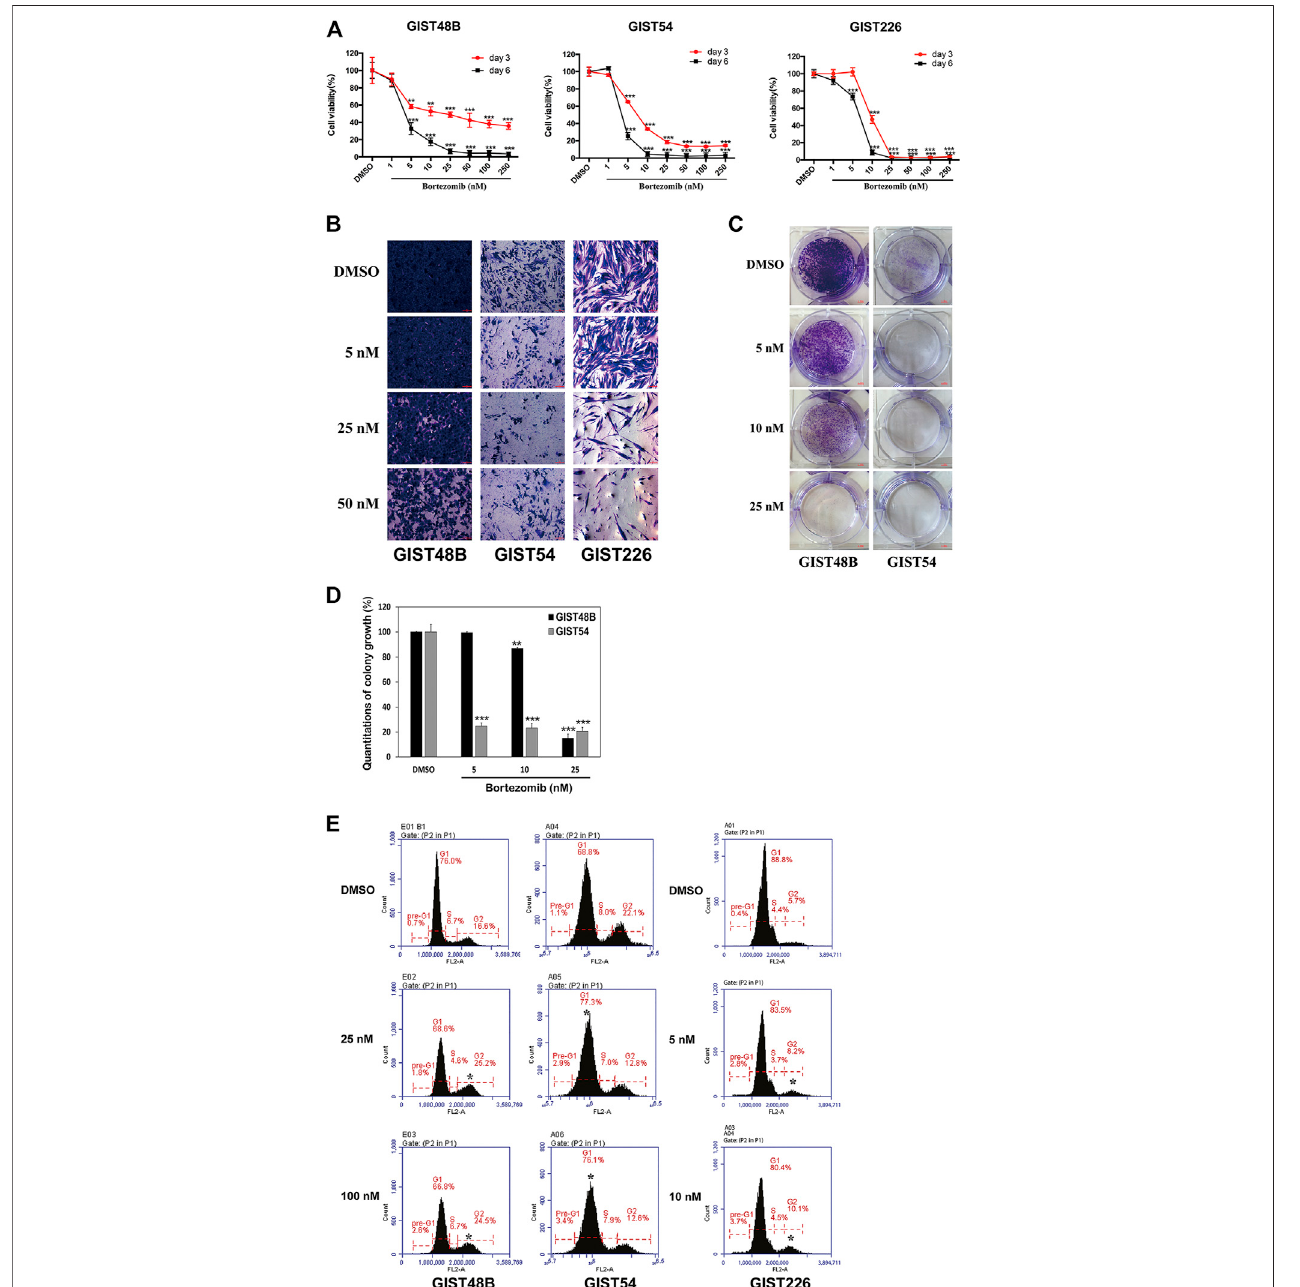
FIGURE3| Anti-proliferativeeffectsofbortezomibinKIT-independentGISTcelllines(GIST48B,GIST54,andGIST226)wereassessedbycellviability,cellimaging, colonyformationassays,andcellcycleanalysis. (A) CellviabilitywasevaluatedbyMTTassaysinGIST48B,GIST54,andGIST226celllines,3and6daysaftertreatment with bortezomib (1, 5, 10, 25, 50, 100, and 250 nM). Data were normalized to DMSO control and represent the mean values ( ± s.d.) from quadruplicate cultures, and were averaged from two independent experiments. Statistically signi fi cant differences between DMSO control and bortezomib treatment are presented as ** p < 0.01, *** p < 0.001. (B) Cell culture appearance of GIST48B, GIST54, and GIST226, when evaluated at 72, 48, and 48 h after treatment with bortezomib (5, 25, and 50 nM) and staining with crystal violet, showing dramatic growth inhibition compared to DMSO-treated control cultures. Scale bars: 100 μ m. (C) Colony growth assays were performed at 7 days after treatment with bortezomib (5, 10, and 25 nM). Colony growth experiments were performed in triplicate. Bortezomib treatment led to a greater reduction in colony formation and size in GIST48B and GIST54 than the DMSO control. (D) Quantitation (A 570 ) of GIST48B and GIST54 cell colony growth after treatmentwithbortezomibfor7 days.Statisticallysigni fi cantdifferencesbetweenuntreatedcontrolandbortezomibtreatmentsarepresentedas** p < 0.01,*** p < 0.001. (E) Cell cycle analysis was performed 72 h after treatment with bortezomib (25 and 100 nM). GIST48B, GIST54, and GIST226 showed a cell population increase in G1/ G2-phase, accompanied by a decrease in G2/G1-and S-phase. Cell cycle experiments were performed in triplicate. Statistically signi fi cant differences between DMSO control and bortezomib treatment are presented as * p < 0.05.